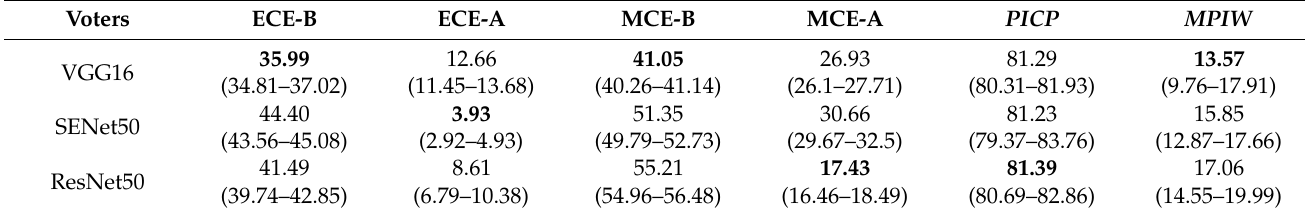
Table 4. Average calibration output of each voter for all participants.